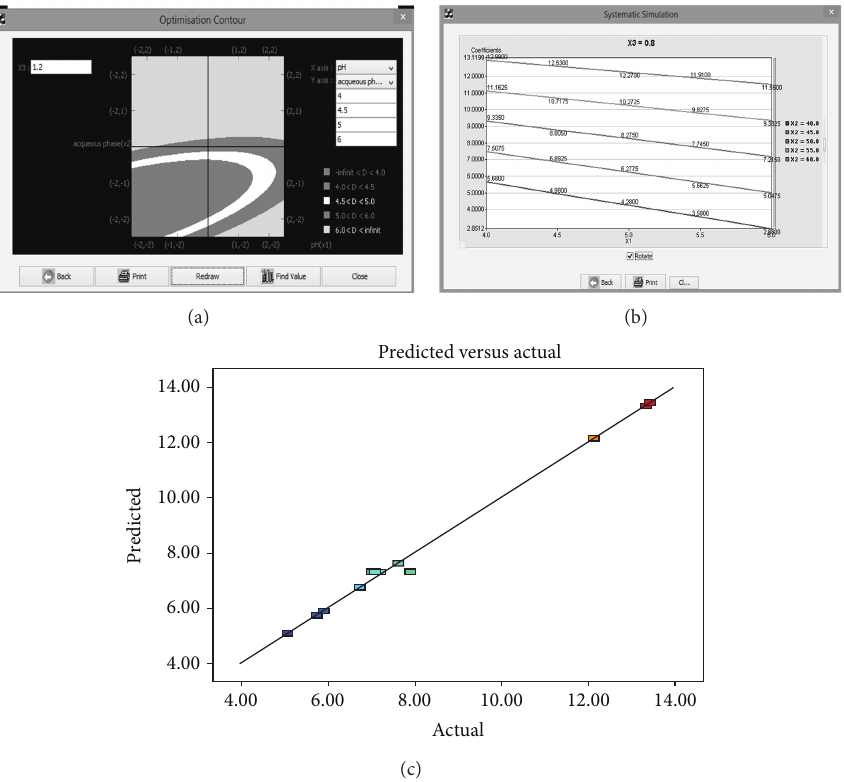
Figure 1: (a) Contour plot for MODR (retention time as method response). The above graph shows the different shade for different region for retention time at different levels − 2, − 1, 0, +1, and +2. (b) Systematic simulation graph for retention time ( 𝑦 -axis) as method response at constant X3 (0.8 mL/min as flow rate) with change in pH (X1- 𝑥 -axis). (c) Graph shows significant correlation between the predicted retention time and actual (experimental) retention time with good correlation coefficient. Table 6: Role of analytical method in pharmaceutical testing and control strategy. S.